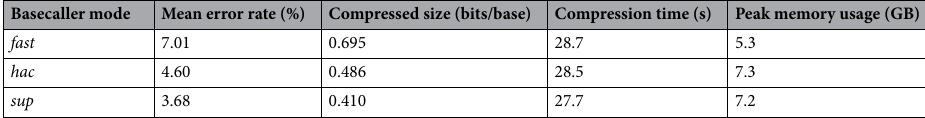
Table 5. Performance of NanoSpring for the S . aureus dataset under different basecaller modes.